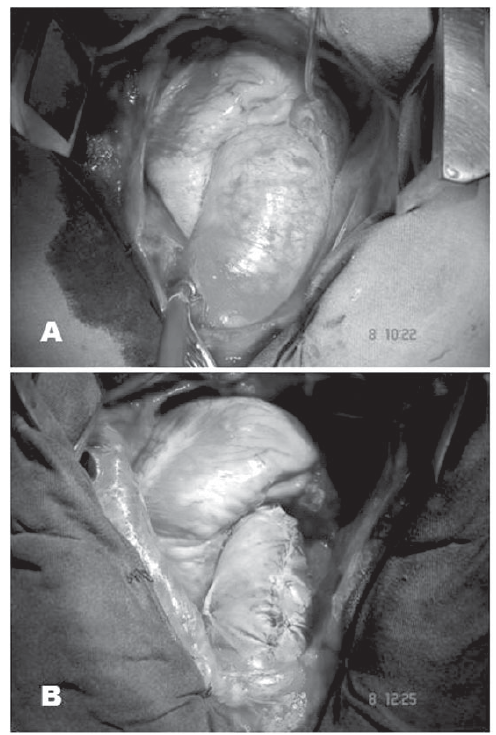
Fig. 1 - Foto cirúrgica. A: Aneurisma de aorta ascendente em paciente com insuficiência valvar aórtica. B: Aortoplastia redutora com contenção externa com malha de nylon